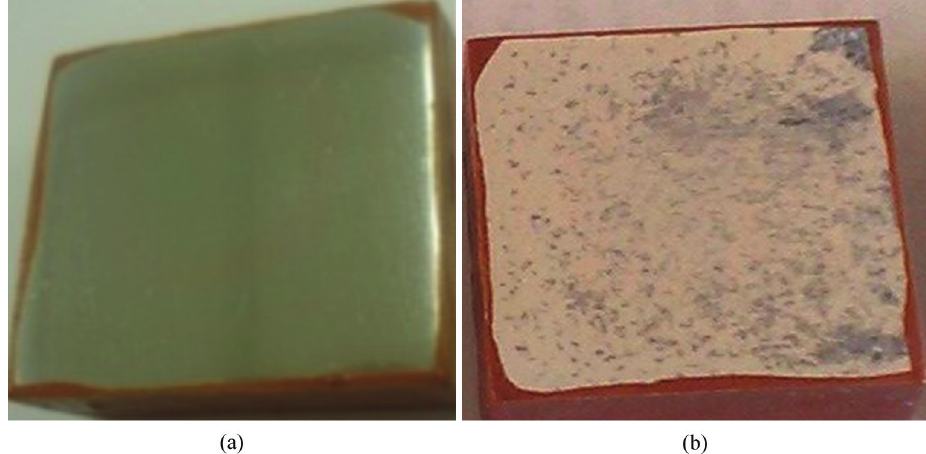
Figure 12. (a) Surface of the sample containing the film deposited in plasmas of 30 W of power, before the test and (b) after 145 h of exposure to salt